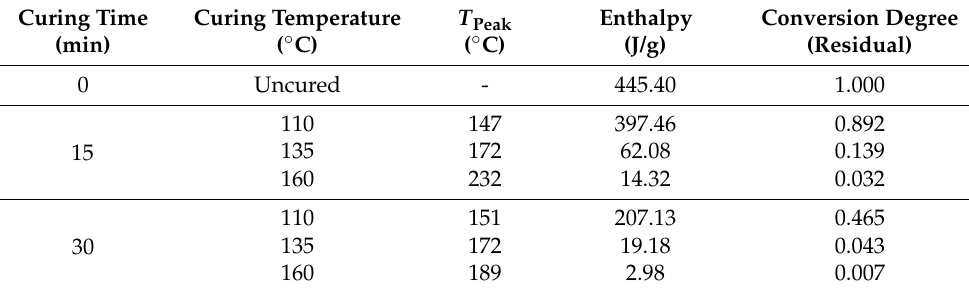
Table 3. Calculated values for resin samples cured at different times and temperatures.